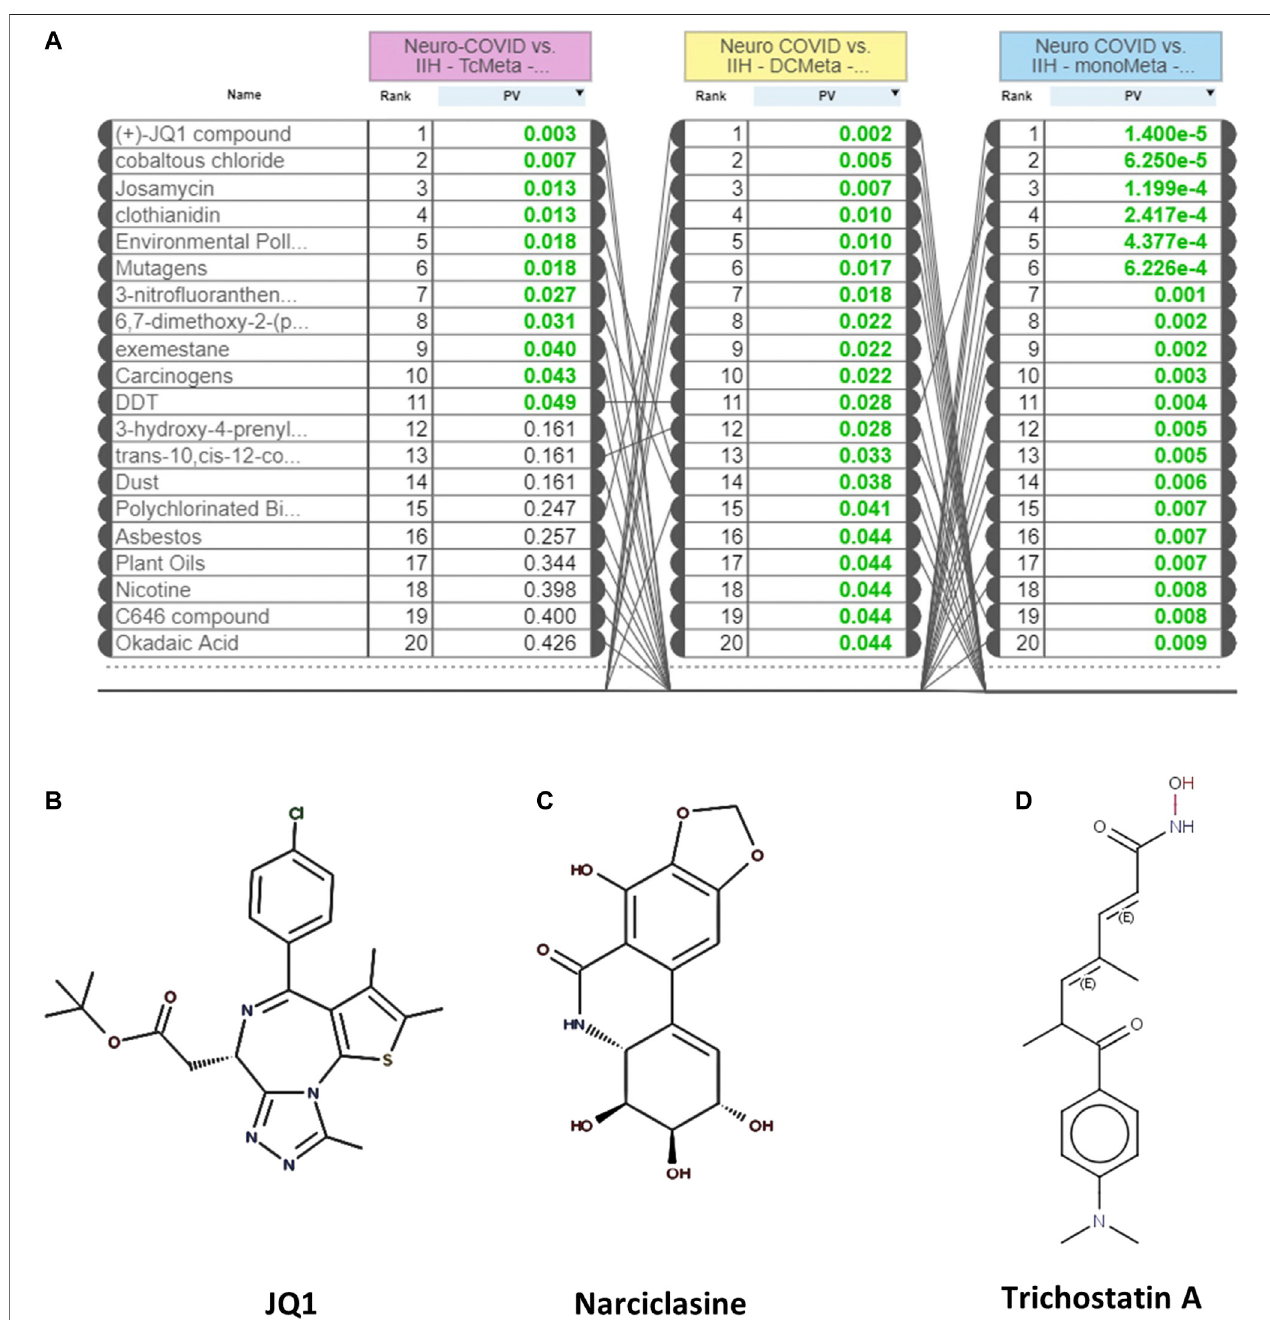
FIGURE 4 | (A) The rank diagram based on the in silico prediction of insuf fi cient signaling of drugs and natural products in TcMeta, DCMeta, and monoMeta using iPathwayGuide analysis. (B – D) The two-dimensional structures of JQ1, narciclasine, and trichostatin A.